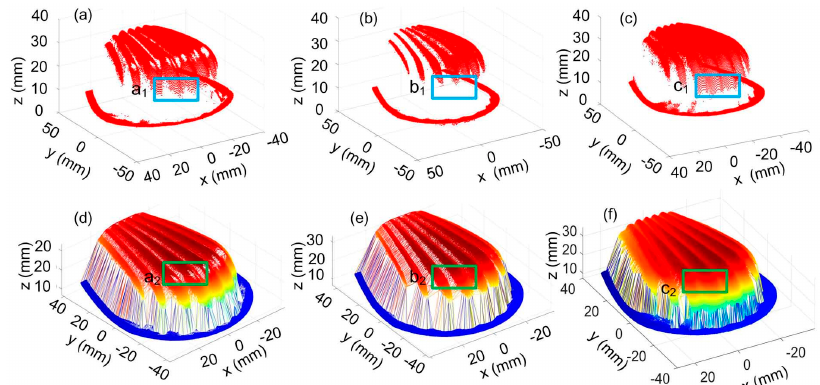
Figure 14. Point cloud data and the triangulated surface of a part with steep feature at different exposure conditions. ( a , d ) The exposure time is T a ; ( b , e ) the exposure time is T b ; ( c , f ) the exposure time is adaptively controlled.